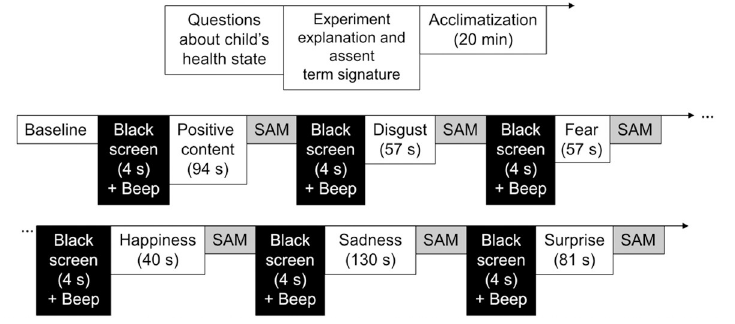
Fig 1. General scheme of the experimental